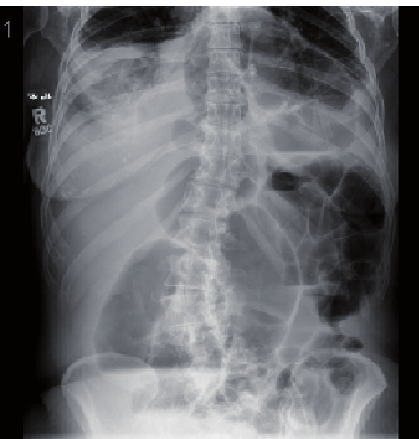
Figure 1: Abdominal radiograph reveals air distended loops of descending and transverse colon. Additionally, a loop of bowel may be seen extending into the pericardial space.